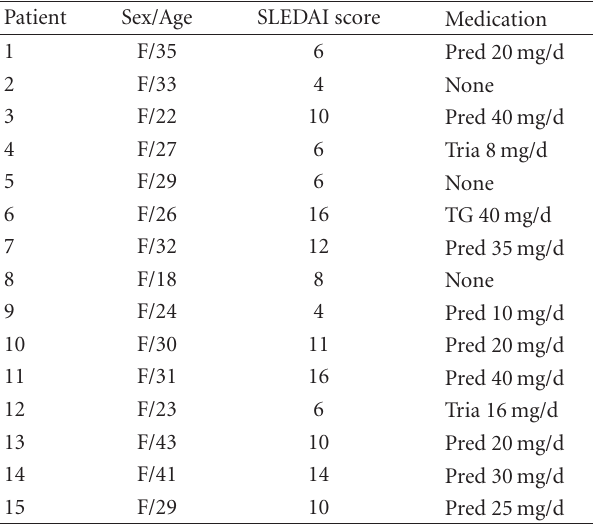
Table 1: Patient demographics,